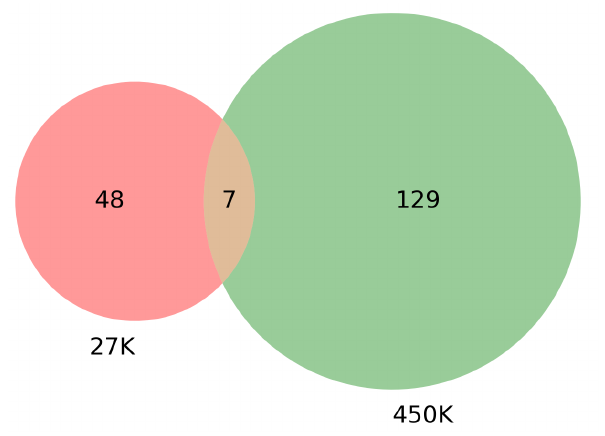
Figure 10. Venn diagram showing the overlap between genes that were found in TSGene + COS- MIC [36–38] and also found in the 585 out of 685 mapped genes in 27K ANOVA-RF with SMOTE and 1290 out of 1572 mapped genes in 450K ANOVA-RF with SMOTE. A summary of these results can be seen in Table 4. Results indicate that 55 genes were common between TS + COSMIC and 27K while 136 between TS + COSMIC and 450K. There were 7 genes common between all of them.